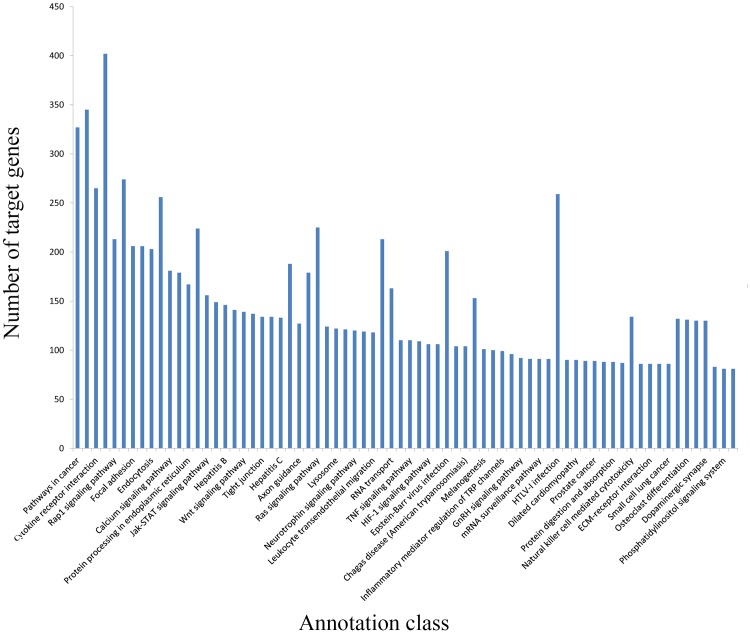
Kyoto Encyclopedia of Genes and Genomes analysis indicating the number of miRNA-targeted genes and the various associated pathways.Horizontal axis indicates the annotated signaling pathways identified, and the vertical axis indicates the number of genes in each pathway to which miRNAs were predicted to bind.